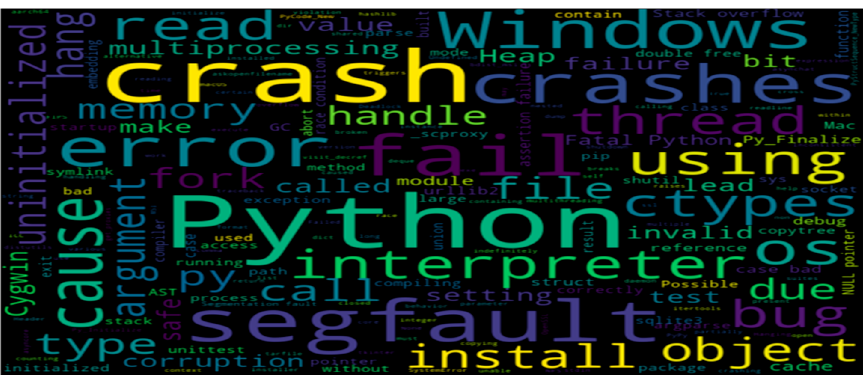
Figure 7. Word cloud of “Enhancement” error.